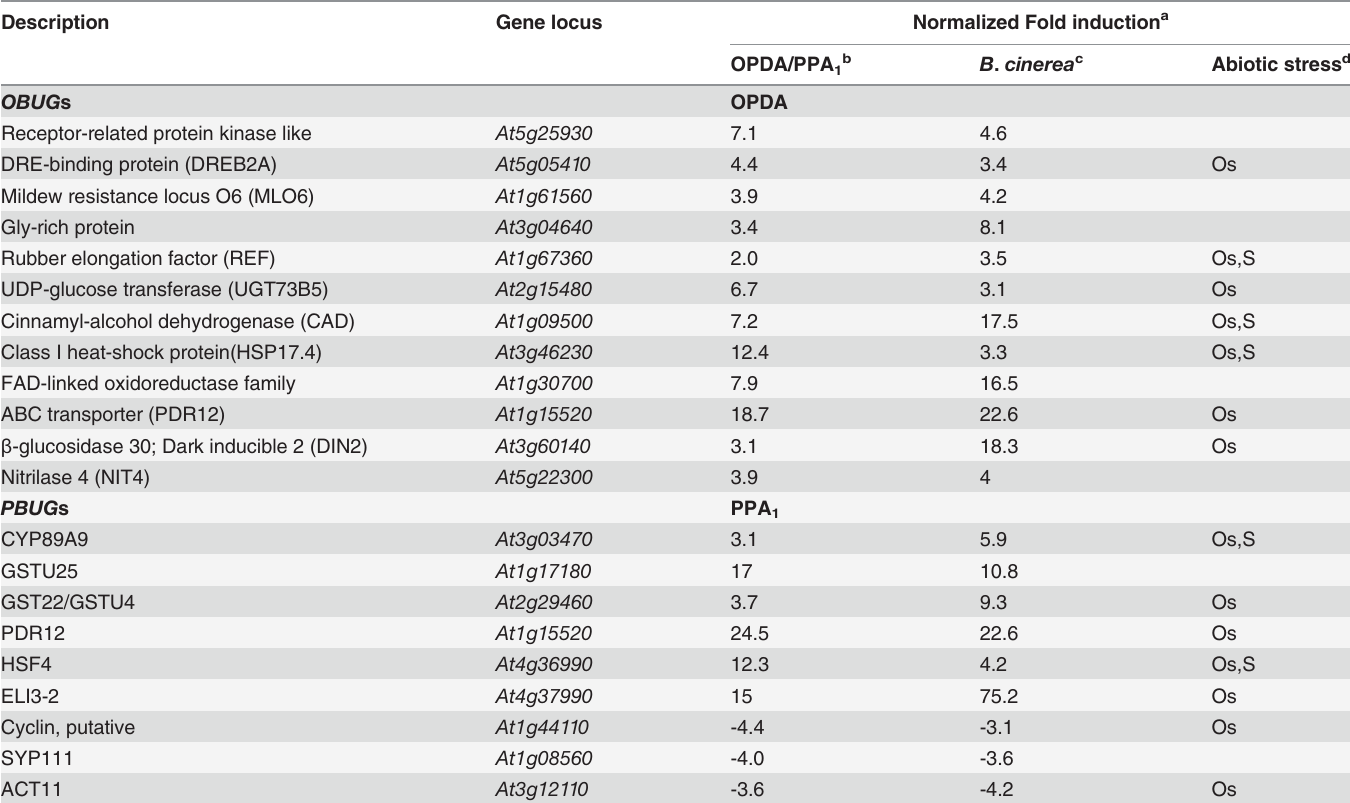
Table 4. Regulation of genes by OPDA or PPA 1 treatment, B . cinerea infection, heat, salinity and osmotic